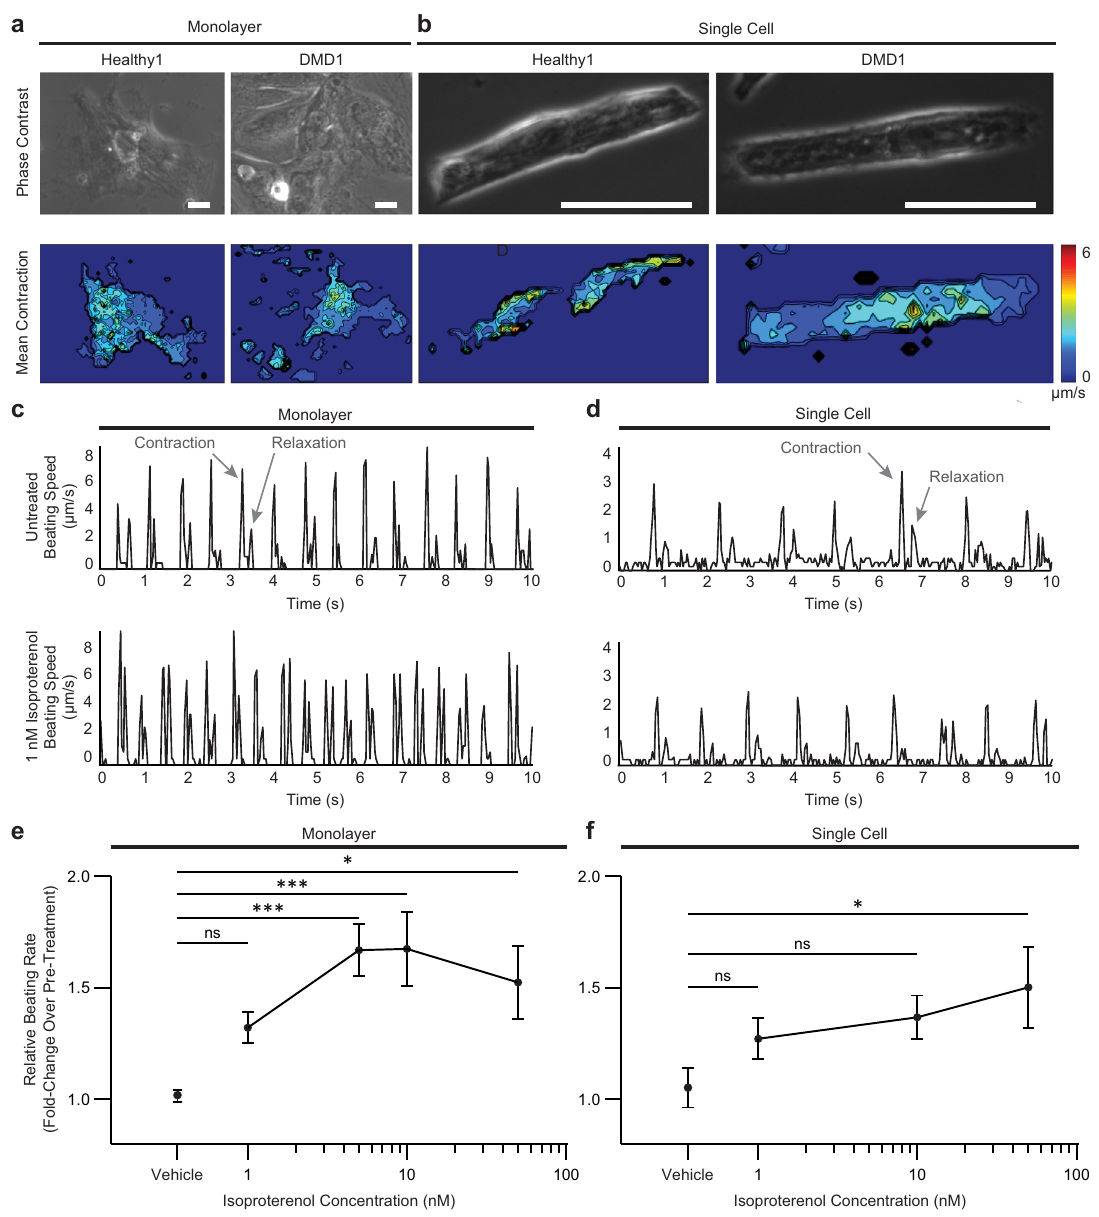
Fig. 3 Video analysis software captures responses to pharmacological stimulation. a , b Representative phase contrast (top) and contractile heatmaps (bottom) for iPSC-CMs in monolayers and as single cells. Scale bars represent 25 μ m. c , d Representative traces of speed over time at baseline (top) and after treatment with 1 nM isoproterenol (bottom) in Healthy1 iPSC-CMs cultured in monolayers and as single cells. Beating speed traces show peaks for both the contraction and relaxation cycles of contraction. Examples of peaks depicting contraction and relaxation are indicated by arrows. e , f Relative beating rate represented as fold change over pre-treatment of Healthy1 iPSC-CMs cultured in monolayers and as single cells in response to increasing concentrations of isoproterenol. Data represent mean ± SEM. Statistical signi fi cance determined by one-way ANOVA and Tukey test for post hoc comparison. * P < 0.05, *** P < 0.001, ns (nonsigni fi cant). n = 3 biological replicates. N = 6 – 17 regions for monolayers and N = 8 – 24 cells for single (MANEX1A) revealed no cytoplasmic dystrophin signal in the results in a dystrophin null phenotype as previously measured DMD1 iPSC-CMs (Fig. 2e). As previously characterized by western by western blot 46 and here by immunostaining with the blot and mass spectrometry, the mutation in DMD1 results in the C-terminal antibody, con fi rming the lack of cytoplasmic dystro- expression of a truncated dystrophin missing the N-terminal actin- phin expression in DMD2 iPSC-CMs (Fig. 2e). The nuclear signal binding domain encoded by exons 1 – 6 44 . Immunostaining with a that is detected in the DMD lines is the Dp71 isoform, the short isoform of dystrophin that is ubiquitously expressed 46,48,49 . These C-terminal antibody (ab15277) demonstrated that this truncated variant, which is missing the essential actin-binding domain, is studies validated that our iPSC-CM model system for the two DMD present in DMD1 iPSC-CMs (Supplementary Fig. 2e). Notably, this and Healthy samples have the appropriate molecular context to partial dystrophin protein is associated with early onset dilated test drug ef fi cacy. Beta-dystroglycan, a component of the cardiomyopathy 47 . DMD2 harbors a nonsense mutation that dystroglycan complex that anchors dystrophin to the extracellular